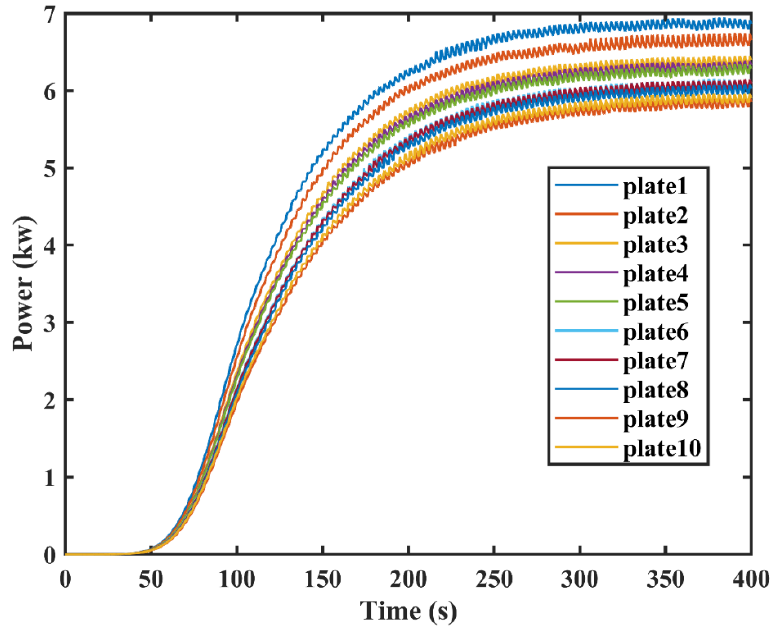
Figure 15. Power output power of the array S-PWEC.